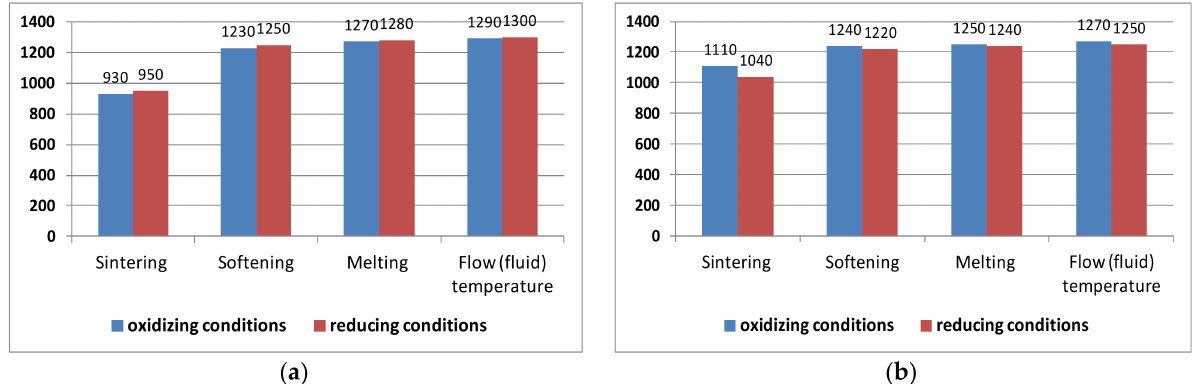
Figure 4. Ash fusion temperatures in oxidizing and reducing environments for lignites used for the UCG tests: ( a ) Velenje, ( b ) Oltenia.